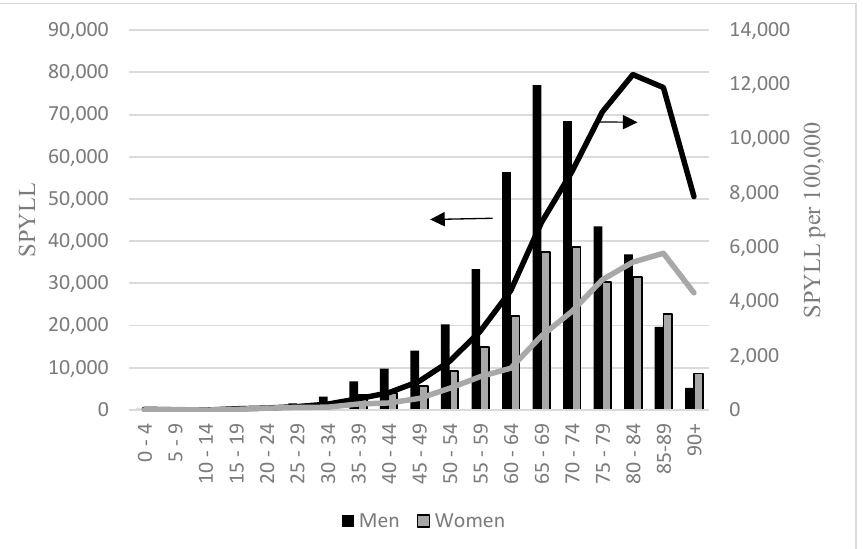
Figure 2. Standard potential years of life lost (SPYLL) among people with COVID-19 in Poland in 2020 by age and sex. SPYLL—scale on the left, columns; SPYLL per 100,000—scale on the right, lines.